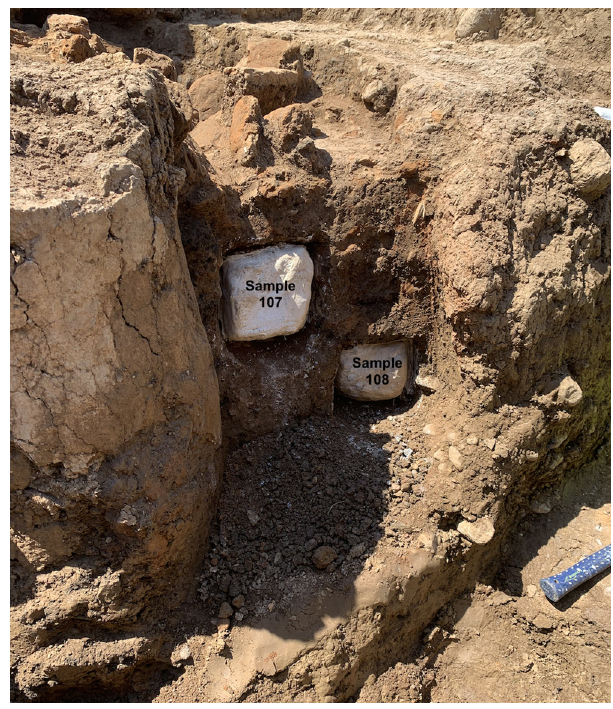
Figure 8: Location of the micromorphological samples 107 and 108 in the kiln fi ll. Photo and annotations by Andrea